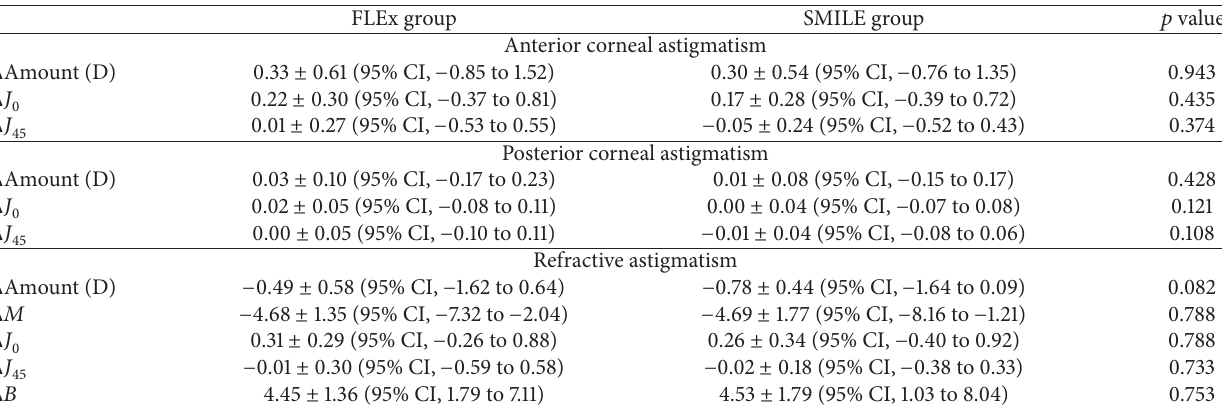
Table 3: Changes in anterior and posterior corneal astigmatism, refractive astigmatism, and refraction after vectorial conversion in eyes undergoing femtosecond lenticule extraction (FLEx) and small incision lenticule extraction (SMILE).